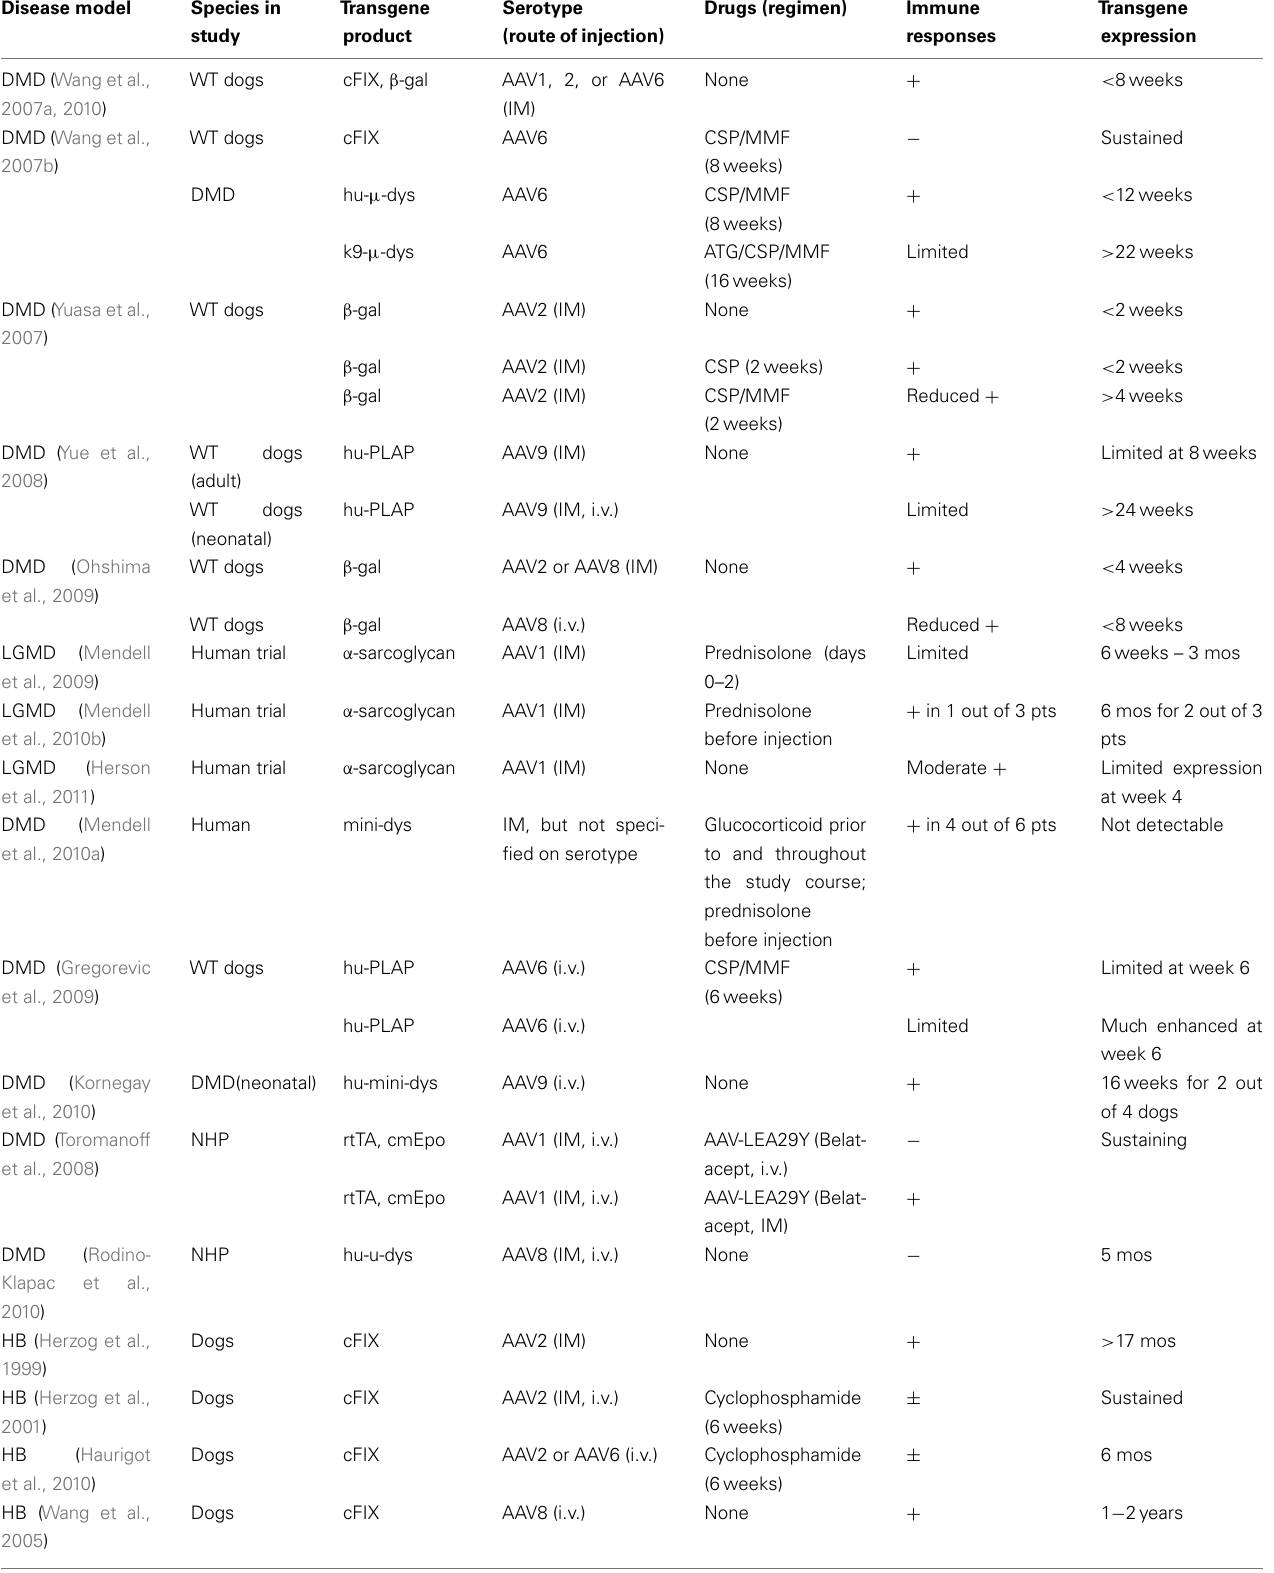
Table 1 | Summary of studies usingAAV gene transfer to muscle. Disease